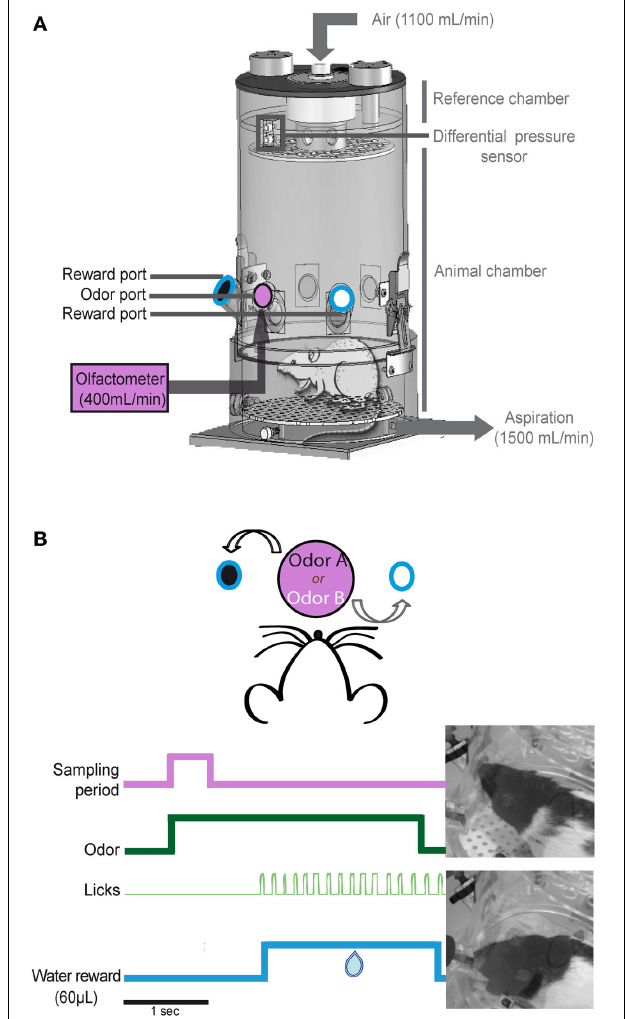
FIGURE 1 | Non-invasive sniff recording. (A) Schematic representation of the whole-body plethysmography. This setup allows us to access the respiratory signal of the animal in a non-invasive manner. The plethysmograph is equipped with three ports: an odor port (pink, central) connected to the olfactometer and two reward ports (black and white circles surrounded with blue lines) equidistant from the central odor port. (B) Example of one trial. The rat starts the trial by poking its nose into the central port; this motion triggers the delivery of an odorant for 3s (green). Each odorant was associated with a reward port: odorant A/left port and odorant B/right port. If the rat makes the correct choice, water is available at the reward port for 6s from the beginning of the trial. The first lick (light green) triggers the delivery of 60 µ L of water